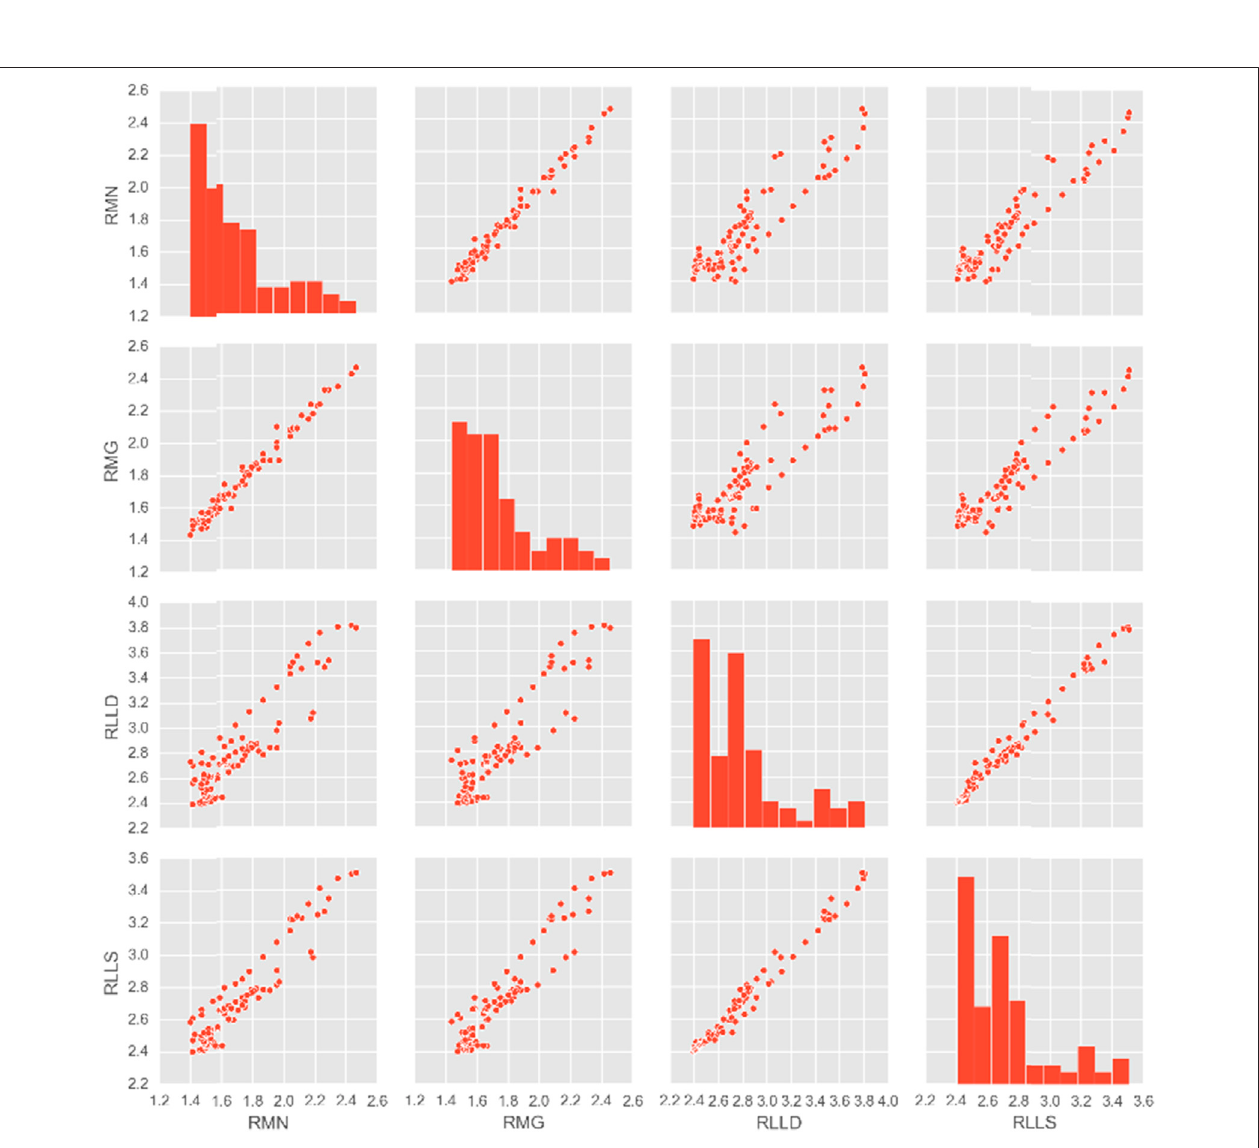
FIGURE 2 | Scatter plot of the correlation among RMN, RMG, RLLD, and RLLS.